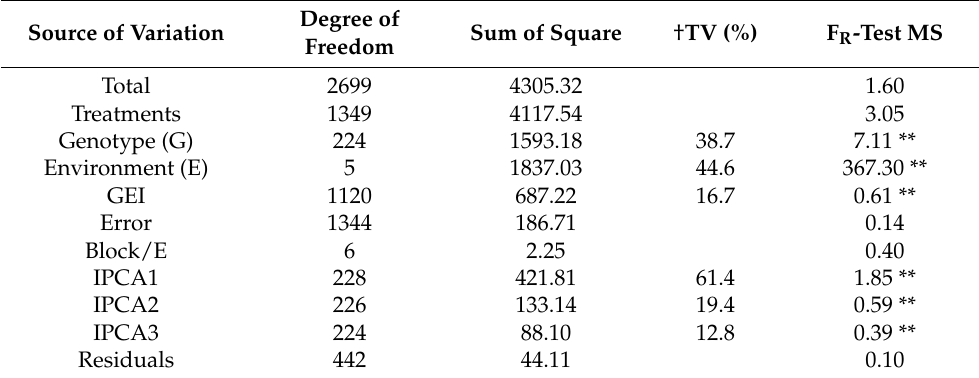
Table 6. Additive main effects and multiplicative interaction analysis of variance for grain yield of 225 sorghum accessions tested in six